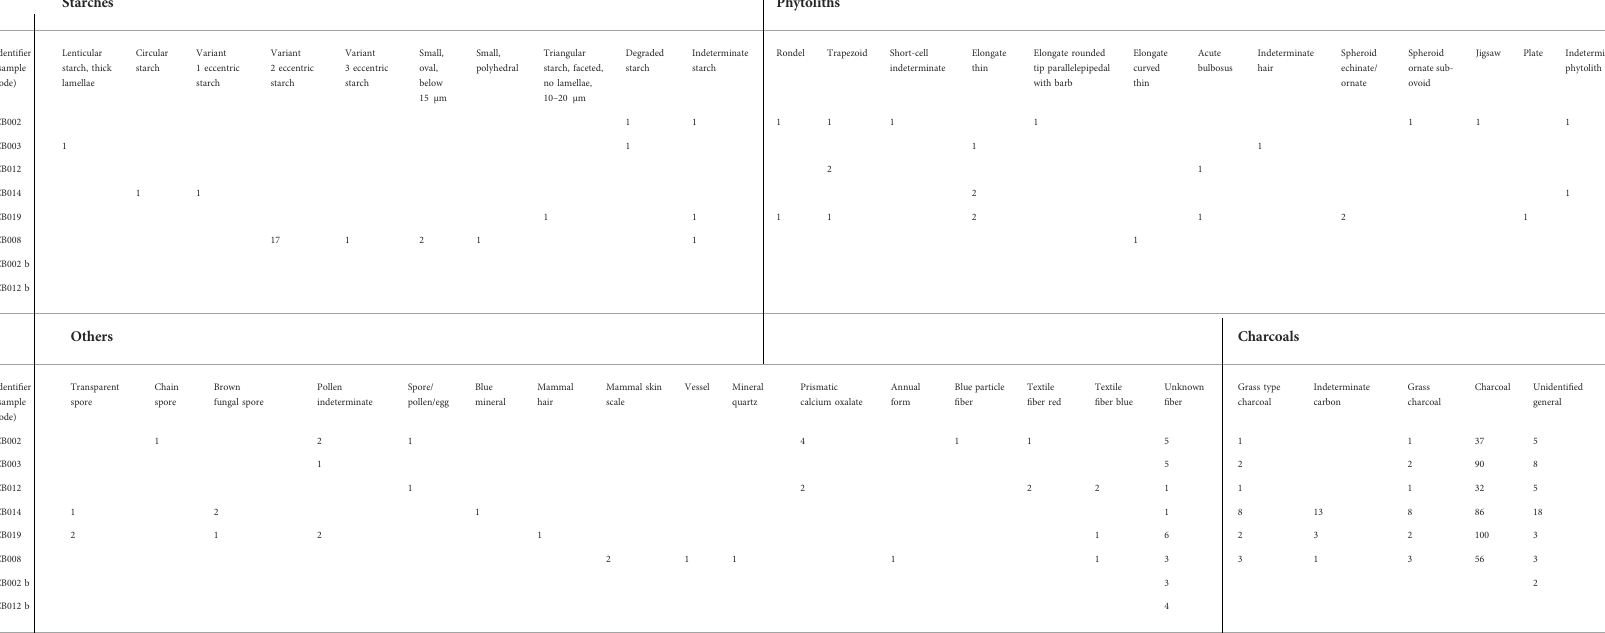
TABLE 3 Chart of total microremains. B samples represent controls. Eccentric starch variant 1: a slightly eccentric starch of variable sizes. Eccentric starch variant 2: a highly eccentric starch of variable sizes. Eccentric starch variant 3: an eccentric faceted starch over 20 microns in